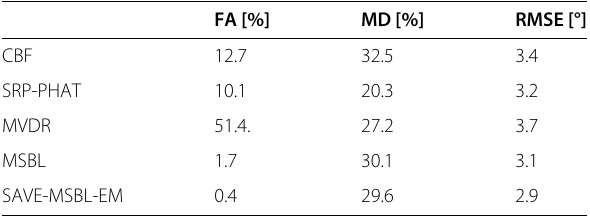
Table 5 Results for the real data FA [%] MD [%] RMSE [°] CBF 12.7 32.5